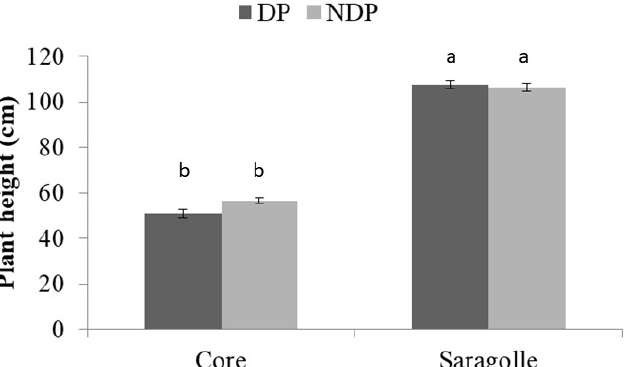
Figure 2. Interaction of wheat variety and clipping management on plant height on 20 May 2021. Bar plots of the mean values and relative standard error bars. Different lowercase letters above the bars indicate significant differences at p < 0.05.